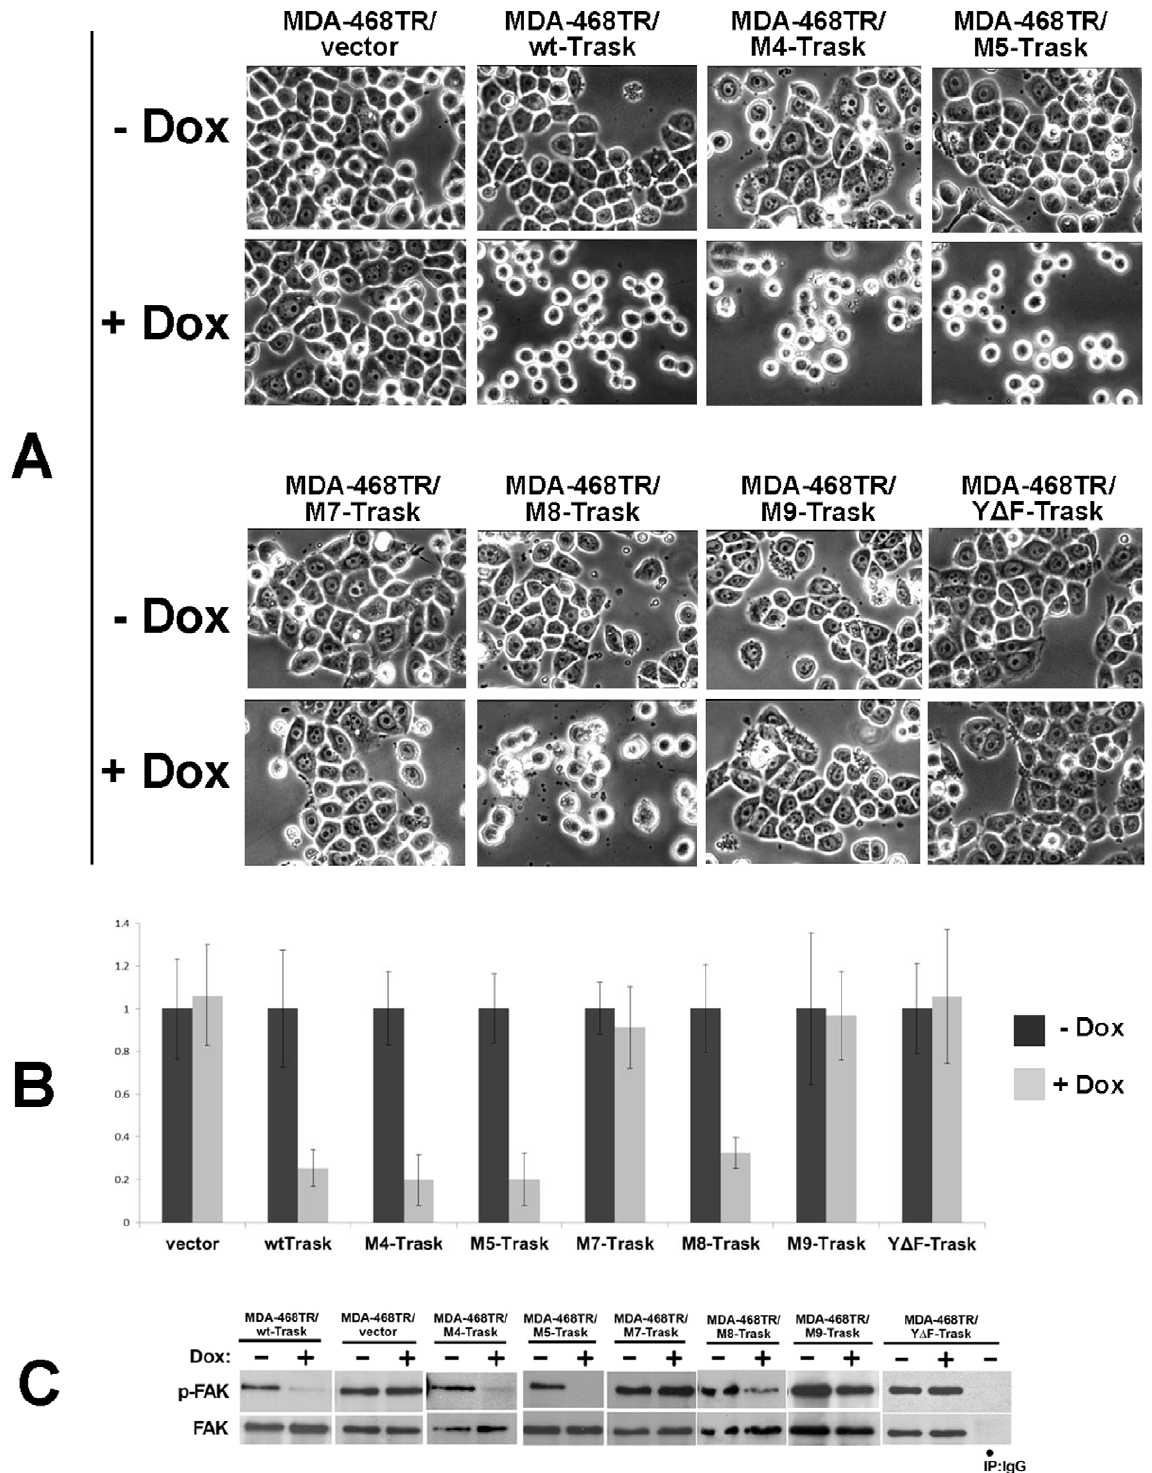
Figure 4. Effects of Trask mutants on cell adhesion. A ) The indicated cell types were plated in 6-well plates in the presence or absence of 1 ug/ ml doxycycline and the following day imaged under phase contrast microscopy. These views are representative of multiple fields of view (shown in Figure S2) and representative of multiple independent experiments ( . 10X for wt, 5X for M4, 3X for M5, 3X for M7, 3X for M8, 3X for M9, and 5X for Y D F). B ) The indicated cell types were treated with 1 ug/ml doxycycline or control and the following day seeded into 96-well plates in triplicate wells and the adherent cell population was quantified by crystal violet staining as described in methods. Results were normalized to non-induced controls, and averaged across the triplicate wells as well as across three independent experiments done on different days (n=9), in different clones, with the indicated SEM. The reduced cell adhesion following dox induction is statistically significant for WT-Trask (p , 0.0001), M4-Trask (p , 0.0001), M5-Trask (p , 0.0001), and M8-Trask (p , 0.0001) cell types. C ) The indicated cell types were treated with 1 ug/ml doxycycline or control overnight and the